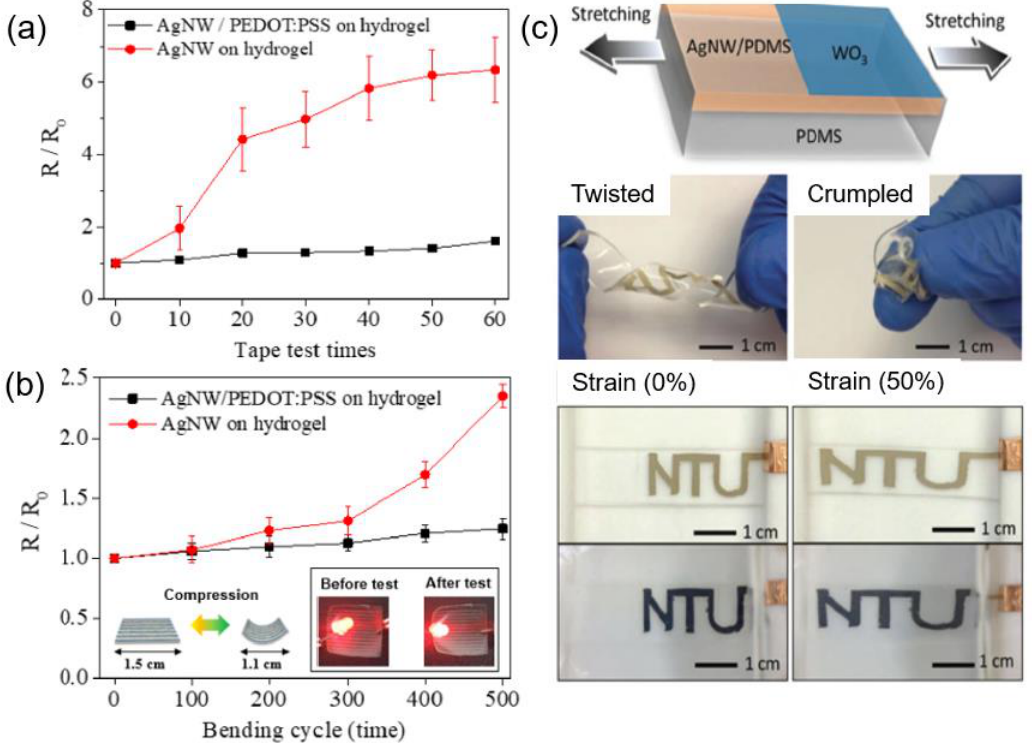
Figure 17. Comparative mechano-electric stability of Ag NWs and Ag NW / PEDOT:PSS composite for ( a ) tape test and ( b ) cyclic bending tests. (Inset: LED emission on Ag NW / PEDOT:PSS electrode before and after bending cycles) [89,90]. ( c ) Ag NW / PDMS composite based stretchable electrochromic device. ( top ) Stretchable devices being twisted / crumpled and patterned electrochromic device in bleached and colored states (0 and 50% strain) ( bottom ). Reproduced with permission from [91,92]. Copyright 2014 American Chemical Society.